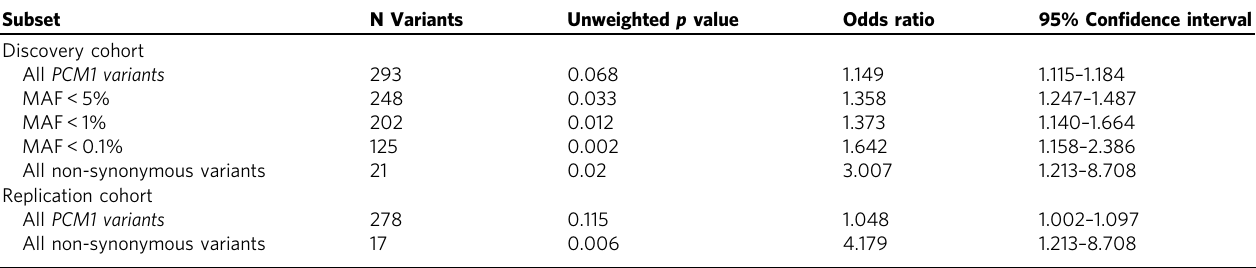
Table 1 Summary of sequencing statistics. Subset